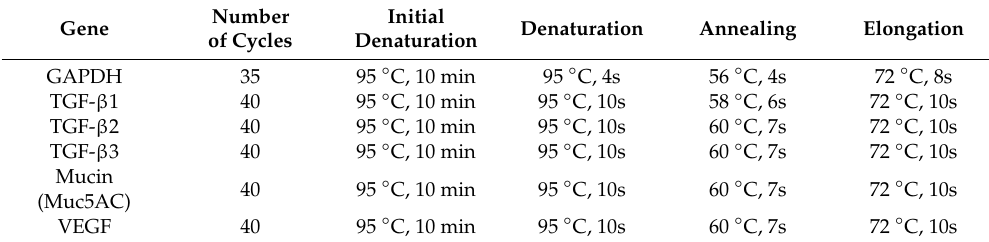
Table 7. Real-time PCR conditions for particular